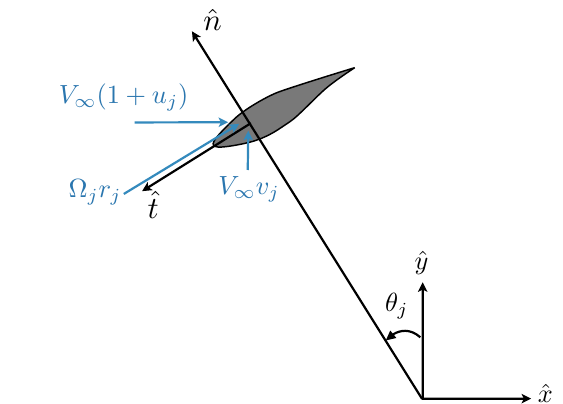
Figure 8. Relative components of velocity in the frame of the air- foil.